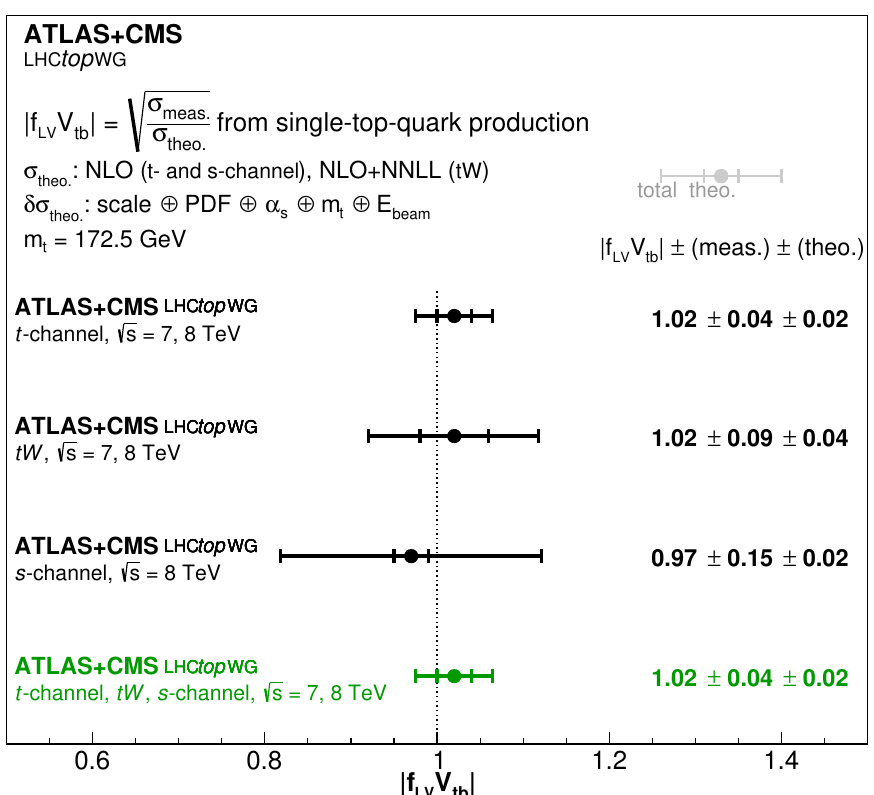
Figure 4 . The combined f LV V tb value extracted from the t -channel and tW cross-section measure- j j ments at p s = 7 and 8 TeV from ATLAS and CMS, as well as the ATLAS s -channel measurement at p s = 8 TeV, is shown together with the combined f LV V tb values for each production mode. The j j theoretical predictions for t -channel and s -channel production are computed at NLO accuracy, while the theoretical predictions for tW are calculated at NLO+NNLL accuracy. The (cid:27) theo : uncertainties used to compute f LV V tb include scale, PDF+ (cid:11) s , m t , and E beam j j